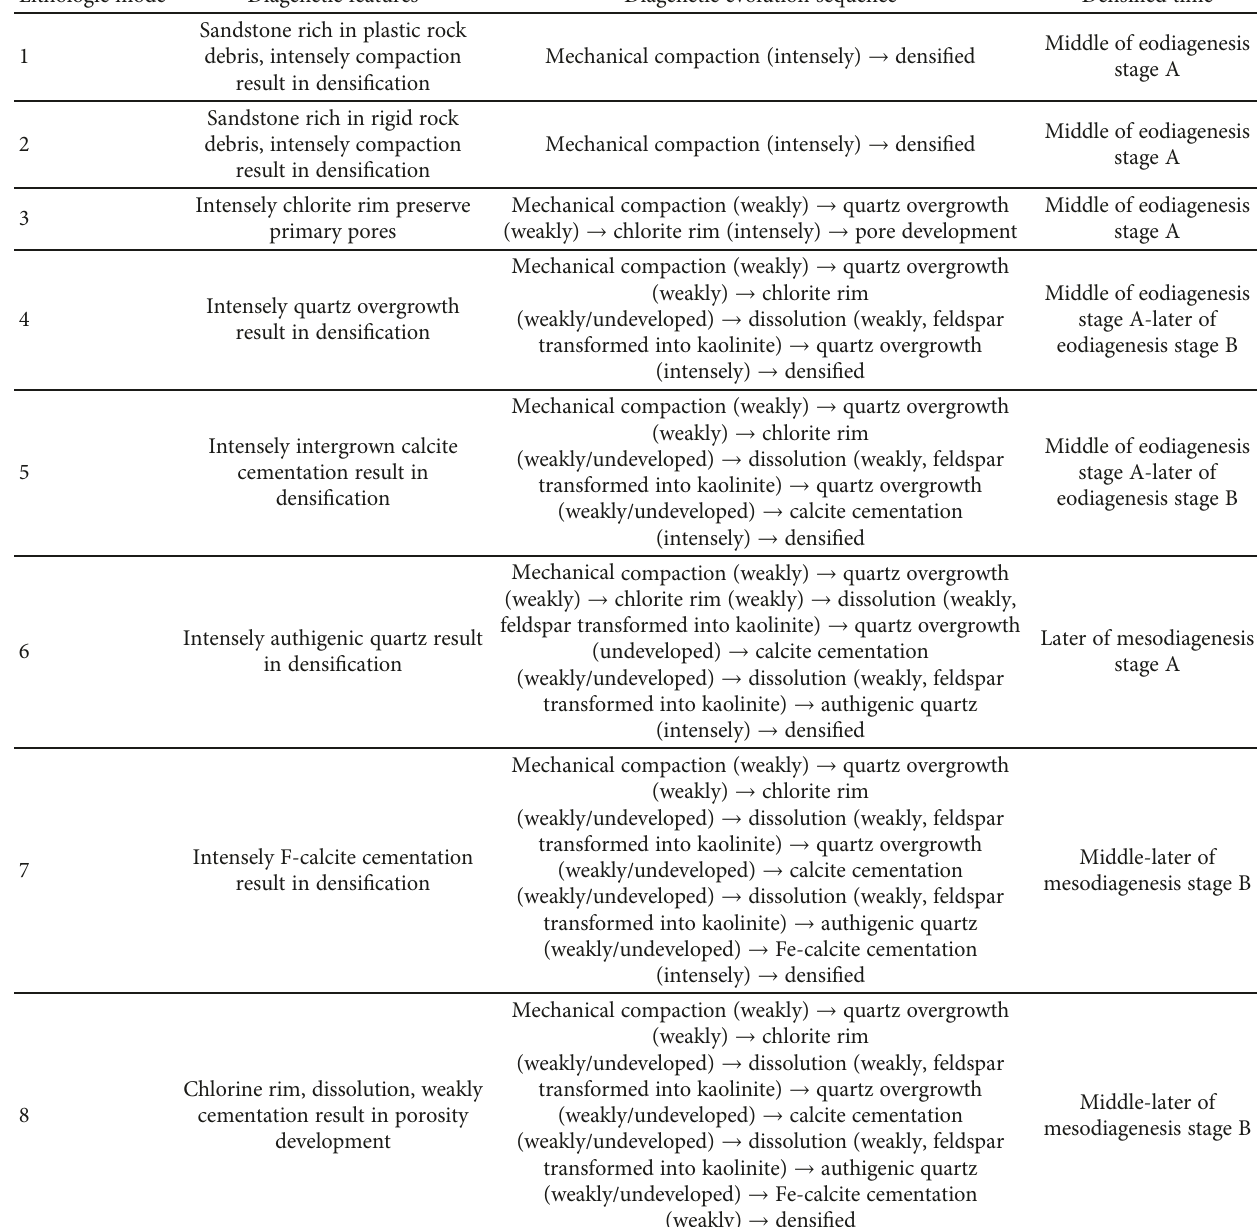
Table 4: Typical diagenetic features and evolution sequence for various lithologic